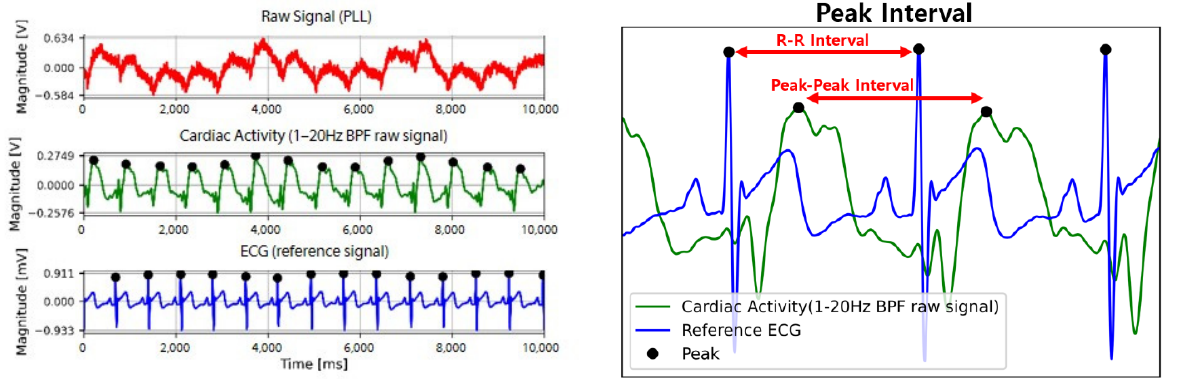
Figure 8. Cardiac activity signals measured using clinical ECG signals and spiral loop sensor at P4 (R-peak–PLL-peak analysis).